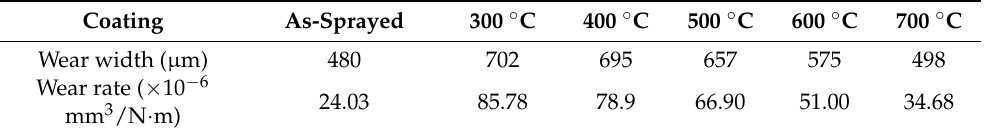
Figure 9. Three-dimensional profiles of the wear tracks after sliding wear test for the coatings. Table 3. Average wear rate of the